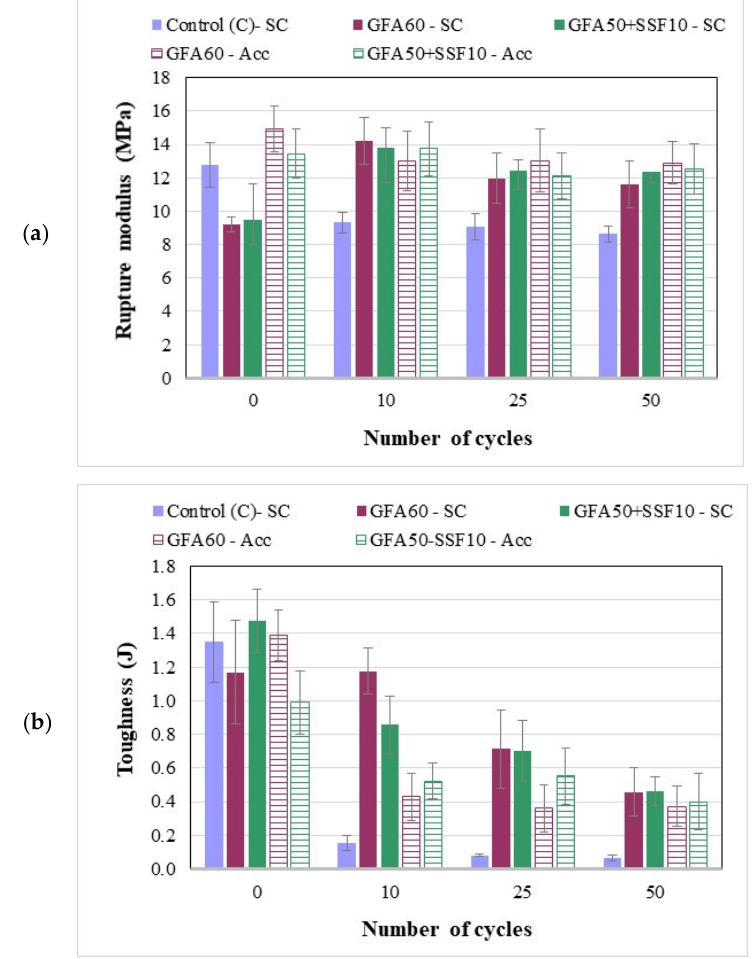
Figure 7. Modulus of rupture ( a ) and toughness ( b ) of the GRC composites subjected to wetting– drying tests in water. drying tests in